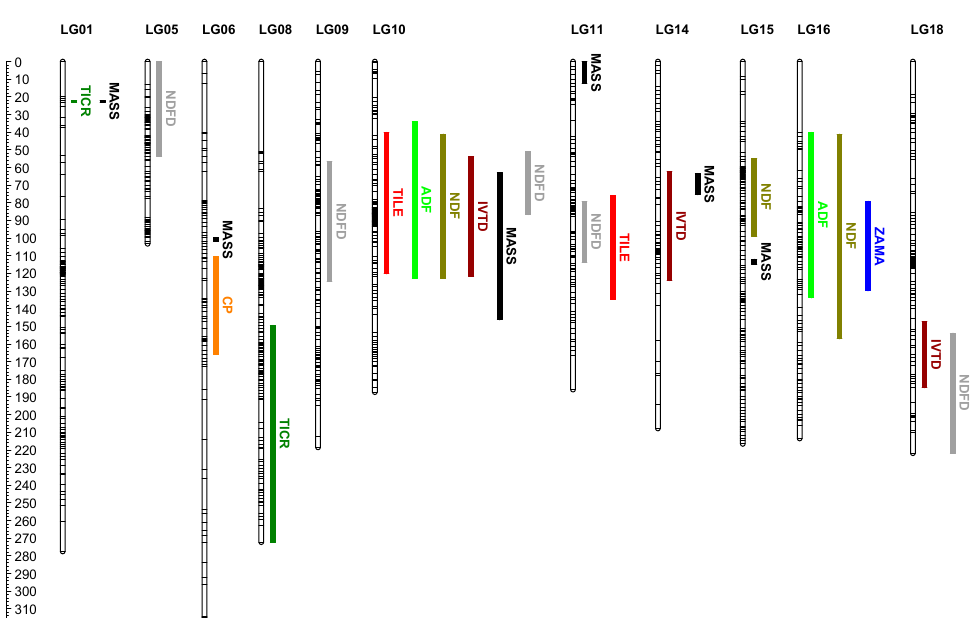
Figure 5. Alignment of quantitative trait loci (QTL) to 11 of the 21 linkage groups of allo-tetraploid (2 n = 6 x = 42) intermediate wheatgrass. The QTL were detected for biomass and morphological and forage nutritive value traits from 192 full-sib progeny (genets) of the M26 × M35 intermediate wheatgrass mapping population evaluated over two years (2016–2017) at Logan, UT, USA in three clonally replicated competition environments (spaced-plants, grass − alfalfa polyculture, and grass monoculture).